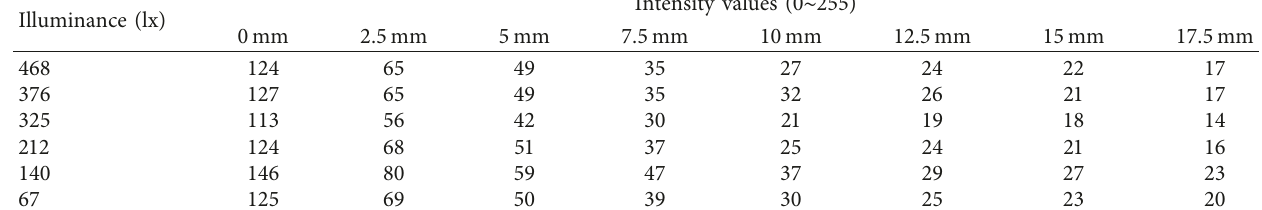
Table 5: Experimental conditions at 2 ∼